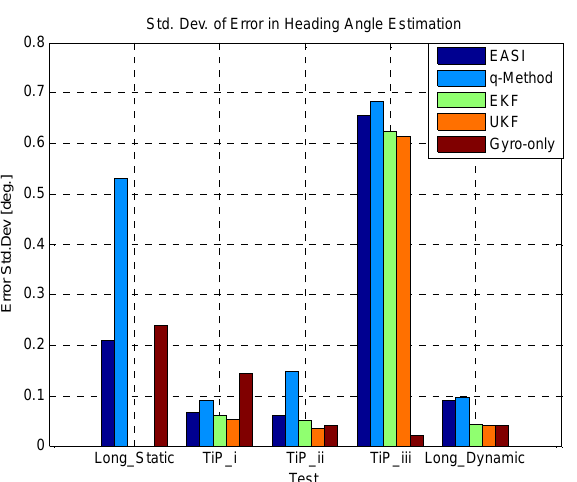
Figure 25. Standard deviation of error in all five tests.